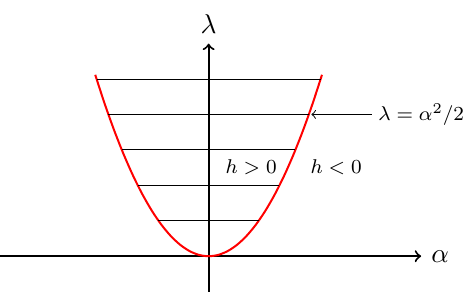
Figure 1 . The region on and above the red curve in the parameter space corresponds to de- formed theories with unitary spectrum while its complement corresponds to those with non-unitary